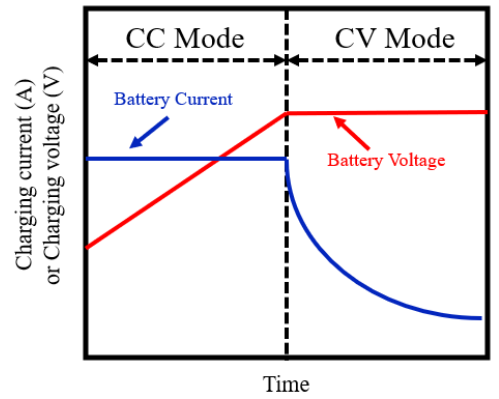
Figure 1. Typical profile of EV battery